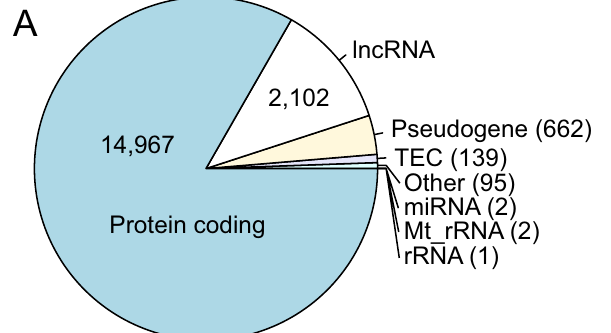
Table S4). Ribosomal proteins L3, L4 and L6, signal peptidase complex catalytic subunit (SEC11C), SMG5 and proline-rich nuclear receptor coactivator 2 (PNRC2) were the most variable between the groups ( p value < 0.05, Table S5) and among translation-related transcripts. These transcripts also displayed a biphasic u-shape (or n-shape, SMG5) BMI relationship (Fig. 4B). Other transcripts that had membership in significant pathways